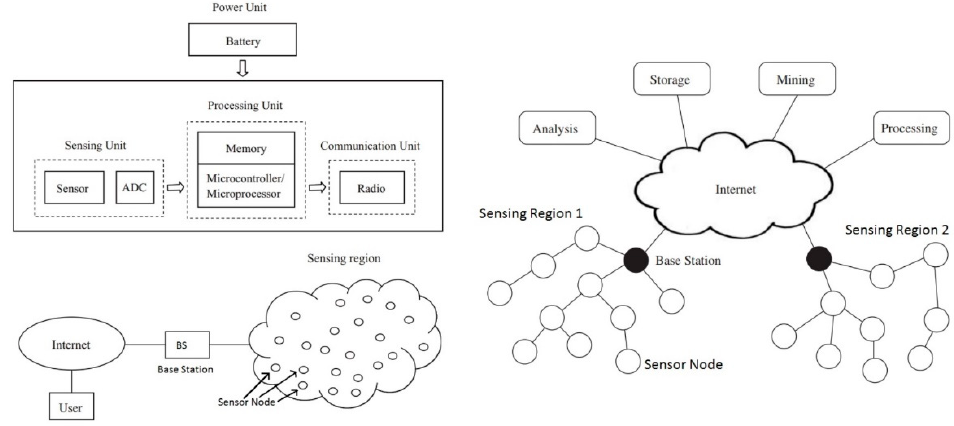
Figure 2. Graphical representation of WSNs for smart cities [25].